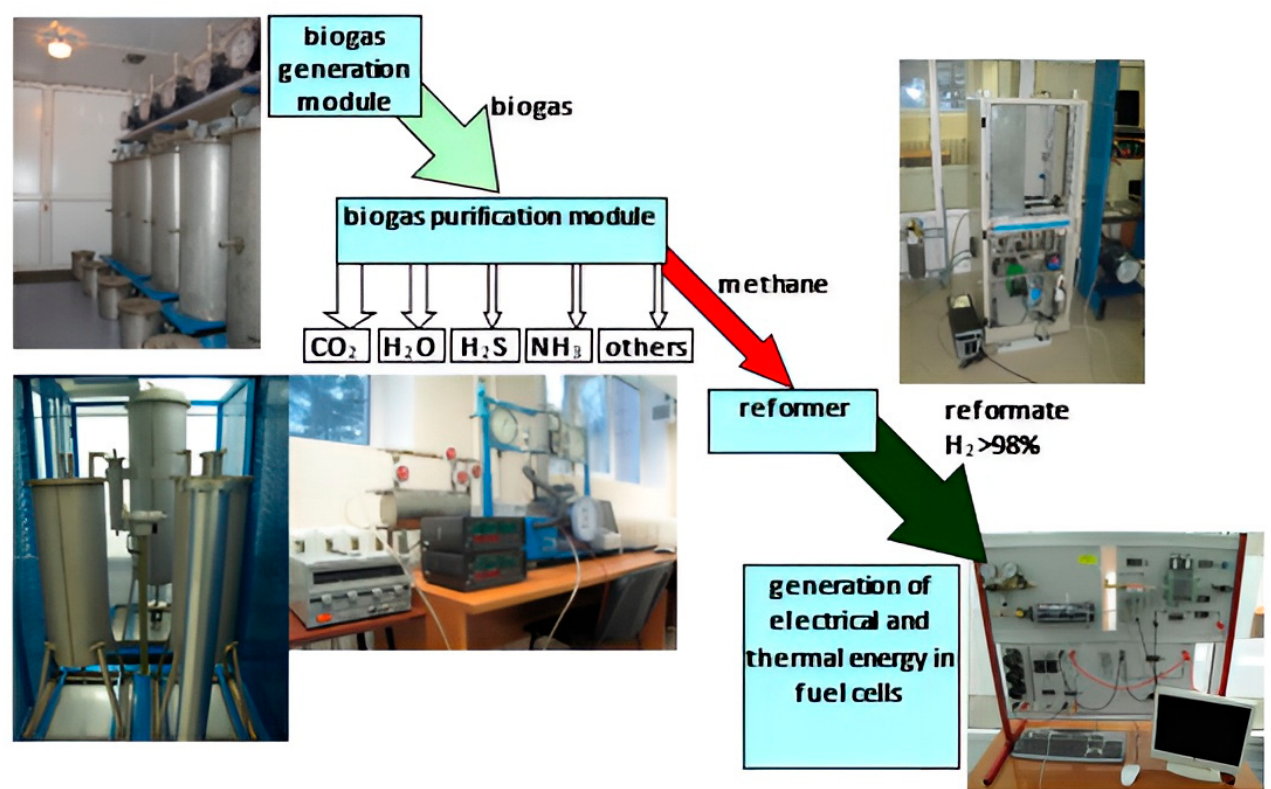
Figure 2. The composition of the modules of the laboratory complex.